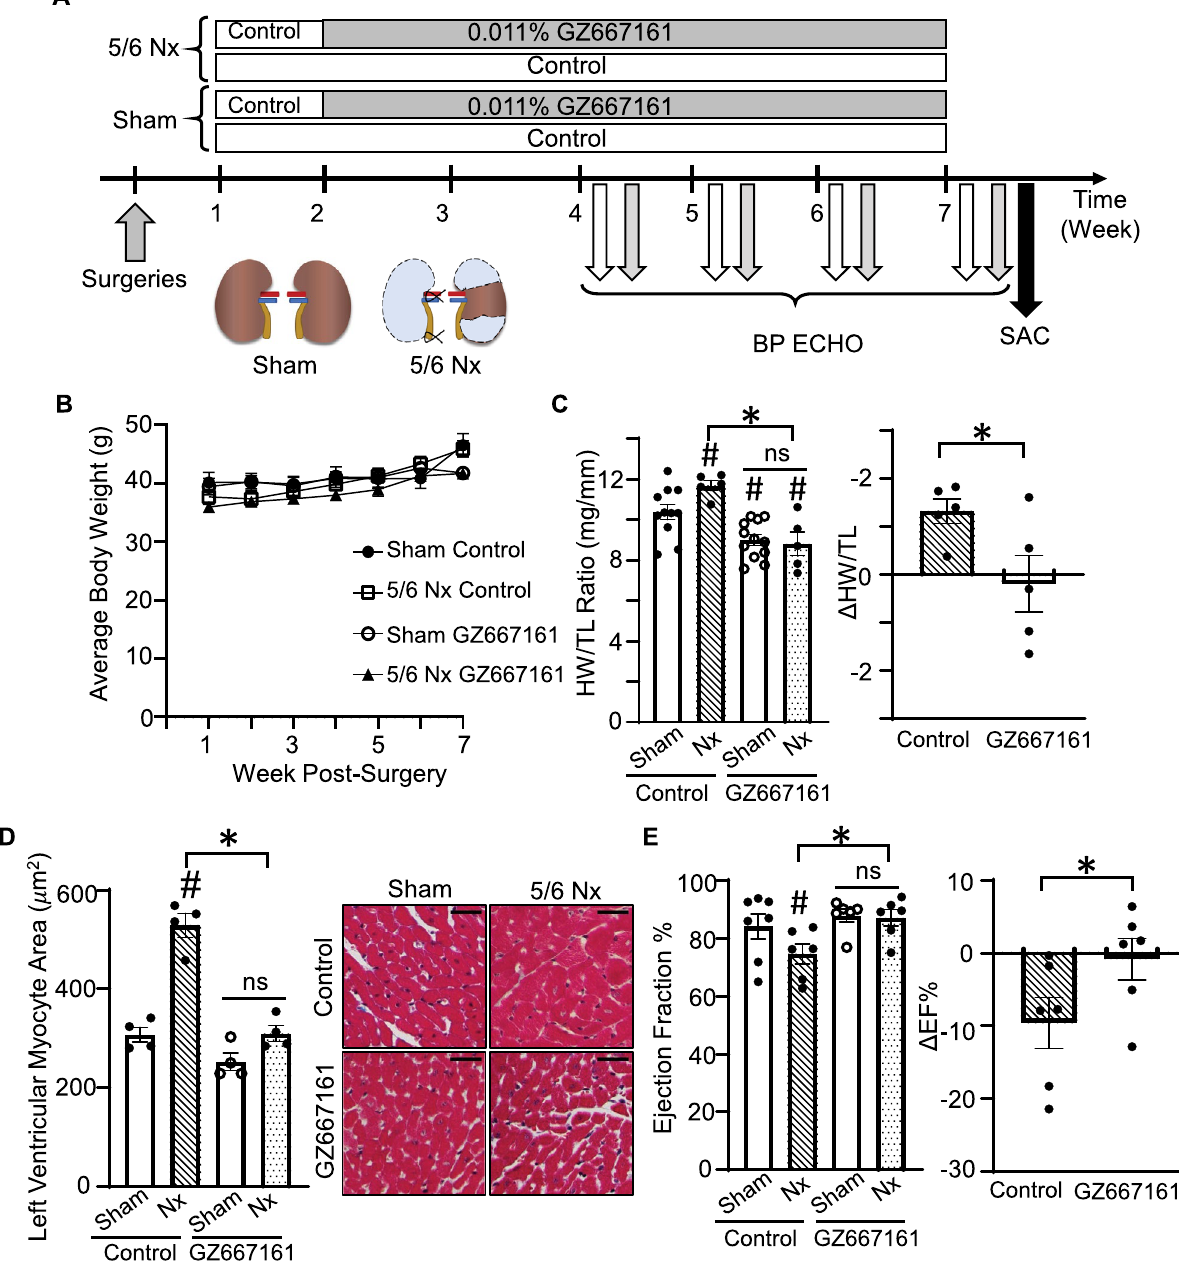
Figure 6. GZ667161 compound exerts cardioprotection on 5/6 Nephrectomy (Nx) Mice. ( A – D ) Mice underwent 5/6 nephrectomy or sham surgery operation. Mice were monitored for 7 weeks. ( A ) Diagram of experimental design for 5/6 Nx mice. ( B ) Average body weight time course post-operation (n = 7,6 sham control, CKD control respectively) (n = 7,5 sham GZ667161, 5/6 Nx GZ667161, respectively). ( C ) HW/TL ratio of mice collected after euthanasia at 7 weeks and the difference in HW/TL between the average HW/TL of 5/6 Nx and sham mice feed with control diet. (n = 11,5 sham control, CKD control respectively) (n = 12,5 sham GZ667161, 5/6 Nx GZ667161, respectively). ( D ) Left ventricular myocyte area. ( E ) Ejection Fraction of sham and control mice measured through ECHO and the difference in EF% in mice compared to control diet fed mice in the respective groups. (n = 7,6 sham control, CKD control respectively) (n = 6,6 sham GZ667161, 5/6 Nx GZ667161, respectively) # P < 0.05 vs. sham control, * P < 0.05 between indicated groups. ns, not significantly different between indicated groups. Data is expressed as mean ± SEM. Note: CKD studies used 0.011% GZ667161